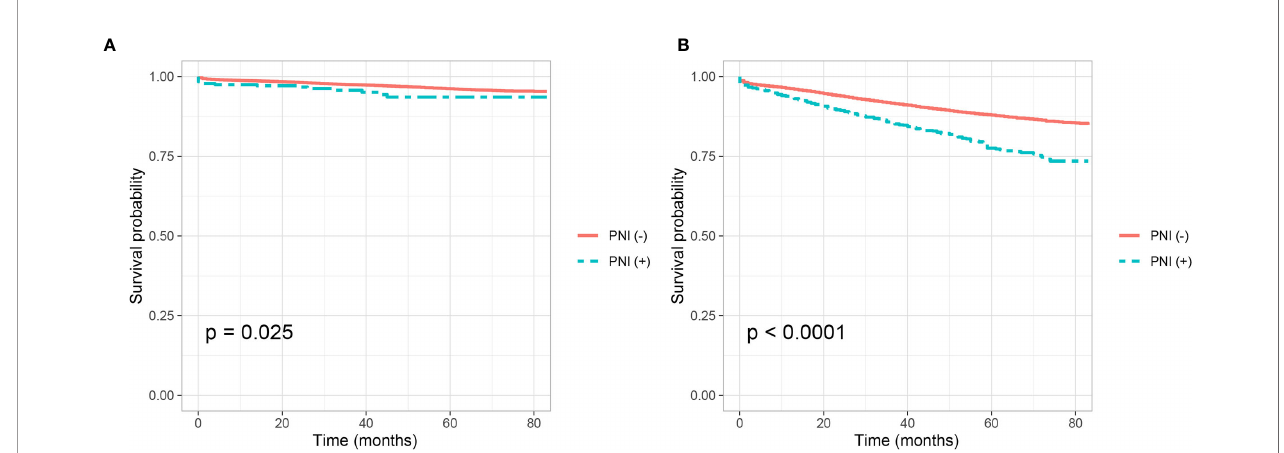
FIGURE 1 | Kaplan – Meier curves for cancer-speci fi c survival according to the perineural invasion status (PNI ( − ) VS. PNI (+) in (A) stage I colon cancer (P = 0.025) and (B) stage II colon cancer (P <0.001).